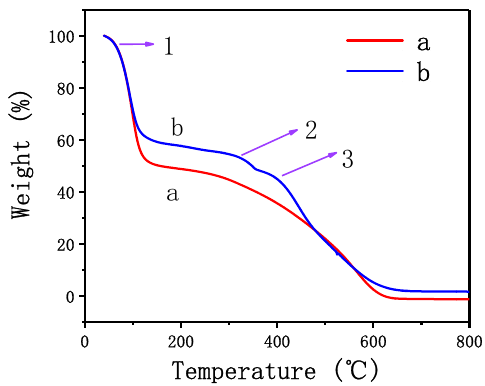
Figure 7. Thermogravimetric analysis (TGA) curves of hydrogenterminated siloxane ( a ) and bio-phenol terminated siloxane ( b ).